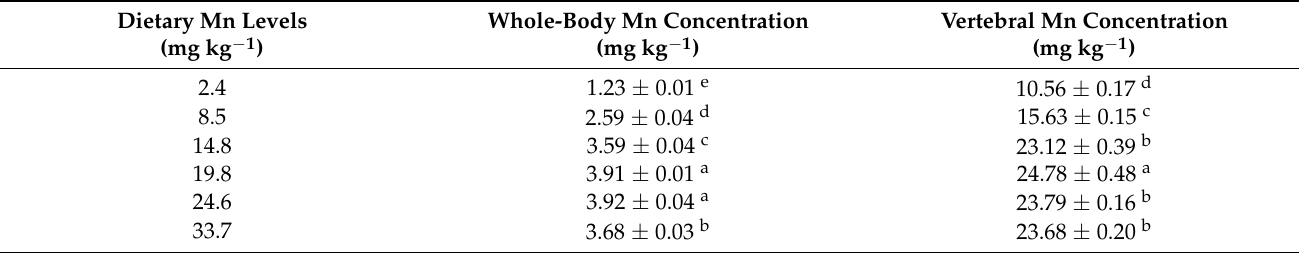
Table 5. The whole-body and vertebral Mn content in the post-larval coho salmon fed a diet with different levels of